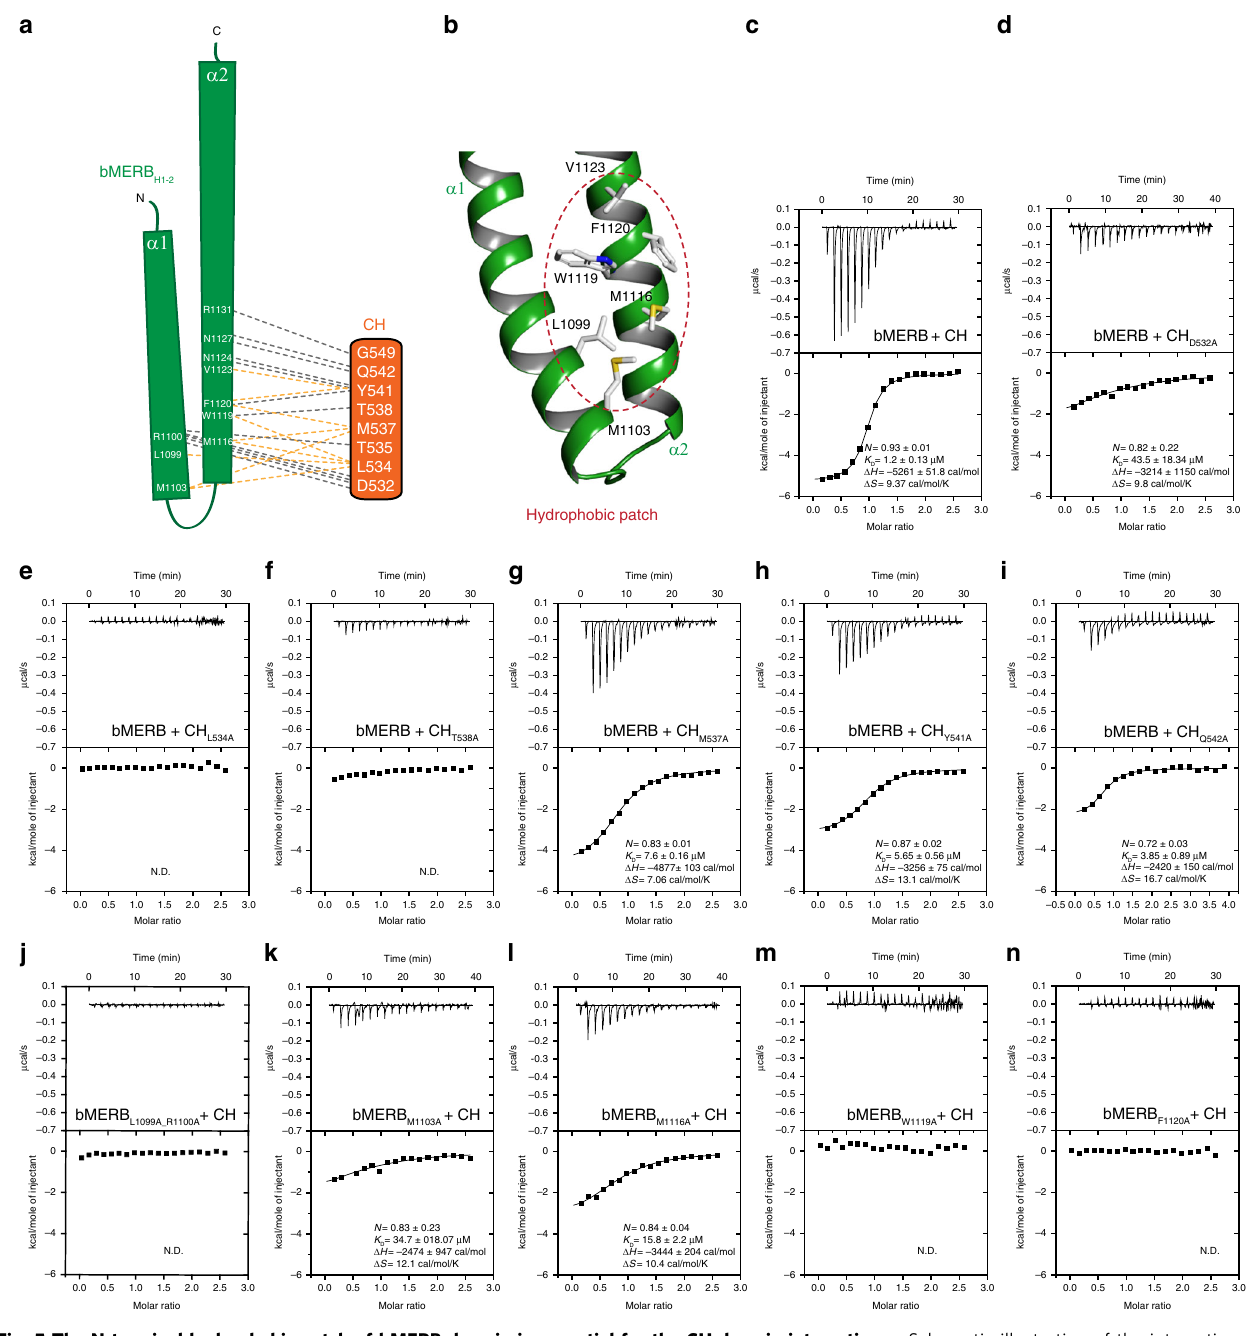
Fig. 5 The N-terminal hydrophobic patch of bMERB domain is essential for the CH domain interaction. a Schematic illustration of the interactions between the bMERB H1-2 domain and the CH domain C-terminal helix. Hydrophobic interactions are indicated by light orange dashed lines, ionic interactions, and H-bonds are indicated by gray dashed lines. b Hydrophobic residues at the CH-binding site of the EHBP1 bMERB domain. c – n Mutational alanine screening of the CH:bMERB complex binding interface via ITC measurements. Mutation of the CH domain residues that are involved in stabilization of the hydrophobic patch results in a signi fi cant defect in binding and the integrity of the hydrophobic patch is crucial for the CH interaction. The data are representative of at least three repetitions. N.D. denotes not